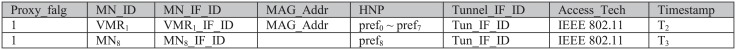
The updated BCE at the LMA.